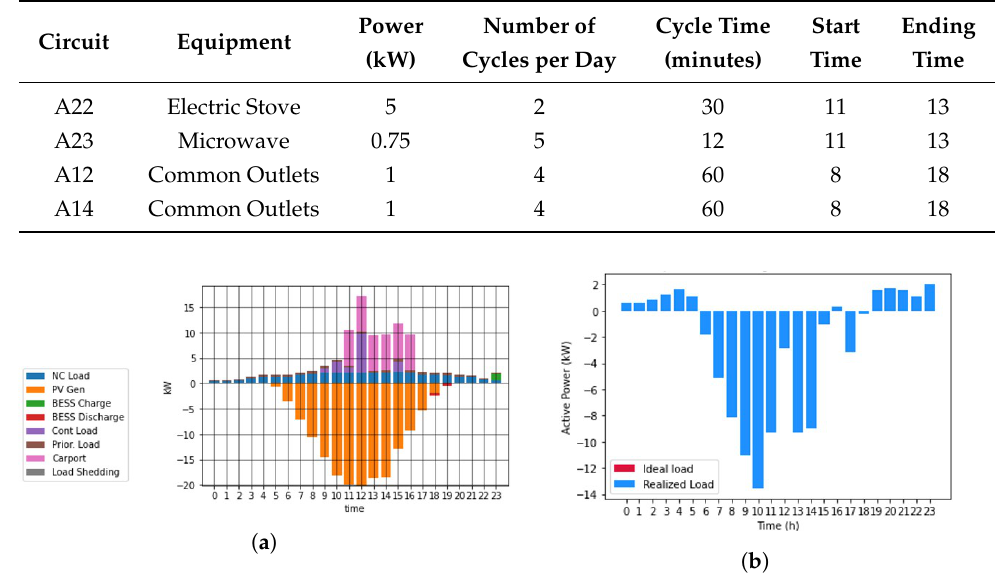
Figure 6. Proposed Dispatch for the Pilot microgrid. ( a ) Microgrid dispatch. ( b ) Dispatch from the point of view of active